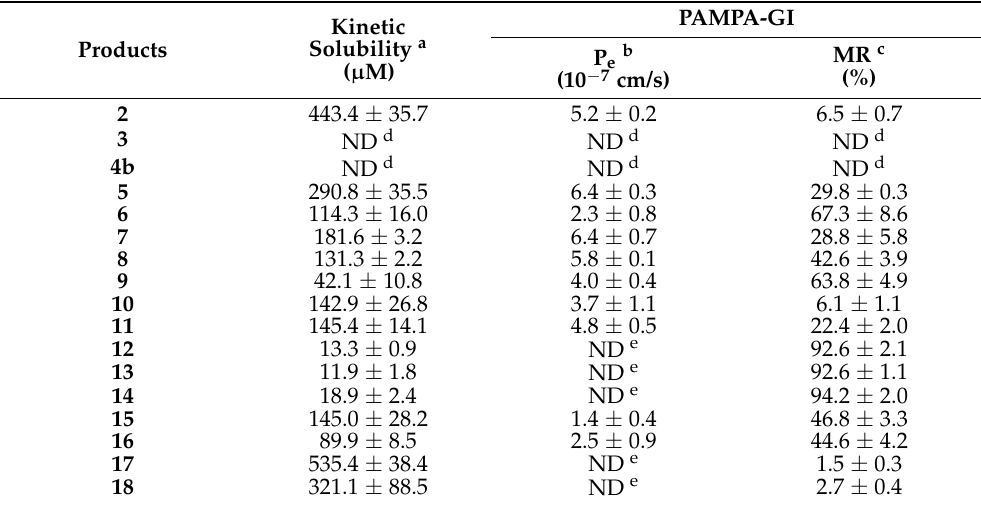
Table 3. Experimental physicochemical characterisation of steviol-based aminotriols. P e : effective permeability, MR: membrane retention. Kinetic aqueous solubility, P e and MR values of PAMPA-GI measurements represent mean ± S.E.M, n =